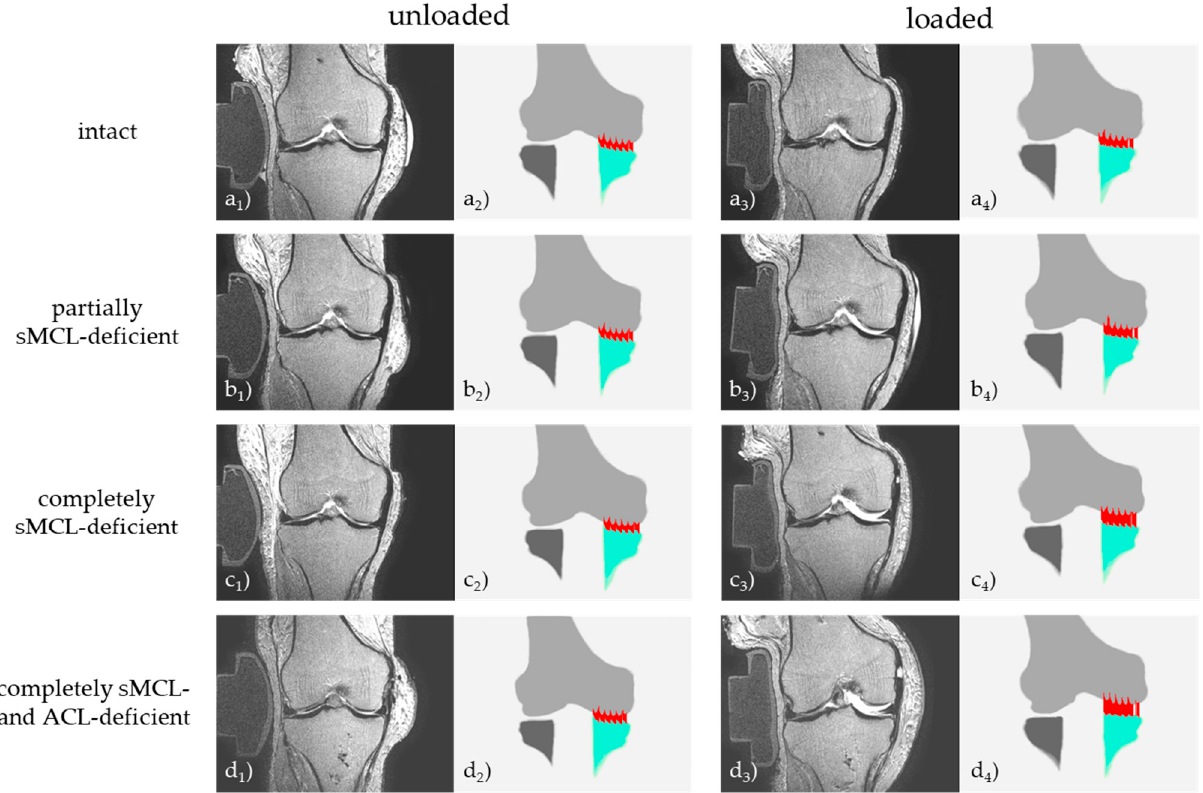
Figure 6. Loading-induced changes in the medial compartment as a function of graded knee joint ligament injury in a representative knee joint. Displayed are T2-weighted mid-coronal images ( a 1 – d 1 , a 3 – d 3 ) and corresponding (coronal) visualizations of the 3D knee joint models ( a 2 – d 2 , a 4 – d 4 ) in the unloaded ( a 1 – d 1 , a 2 – d 2 ) and loaded ( a 3 – d 3 , a 4 – d 4 ) configurations and the indicated joint conditions. Color codes are as follows: femur (light grey), tibia (turquoise [medial compartment] and dark grey [lateral compartment]). Vertical red lines indicate individual measurements of subchondral cortical distances. sMCL—superficial medial collateral ligament. ACL—anterior cruciate ligament. Figure 7 plots the SCD values (as imaging surrogates of medial compartment opening) in a spatially resolved